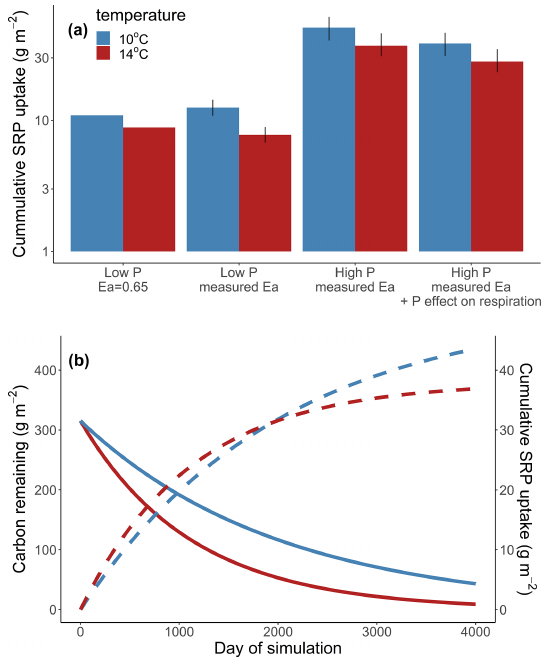
Figure 4. Simulations of the effect of temperature on cumulative soluble reactive phosphorus (SRP) uptake in four scenarios (a) . First, we consider the effect of warming when the activation energy of respiration and uptake are both 0.65eV (low P, 0.65eV). Second, we consider the effect of warming using the measured temperature dependence respiration and uptake at 19µgL − 1 (low P, measured E a ) . Third, we consider the effect of warming at a high initial con- centration of 111µgL − 1 (high P, measured E a ) . Finally, we consid- ered the effect of warming at a high concentration where nutrients also affected the rates of respiration (high P, measured E a + P effect on respiration). Note the y axis in (a) is log 10 -transformed. We also include an example simulation from a cold and warm scenario using the temperature dependence from the high-SRP scenario (b) . Mass of carbon (solid lines) and cumulative uptake of SRP (dashed lines) are presented over time for both temperatures, which are indicated by color. Model parameters used in each scenario are summarized in Table